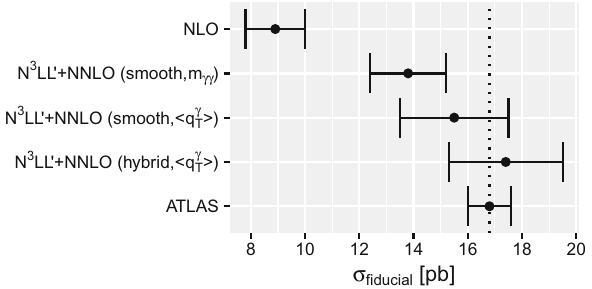
Fig. 1 Comparison of selected fiducial cross-sections from Tables 1, 2 and 3 with the 8 TeV ATLAS measurement. Here both the q ¯ q and loop-induced gg channel contributions are added together